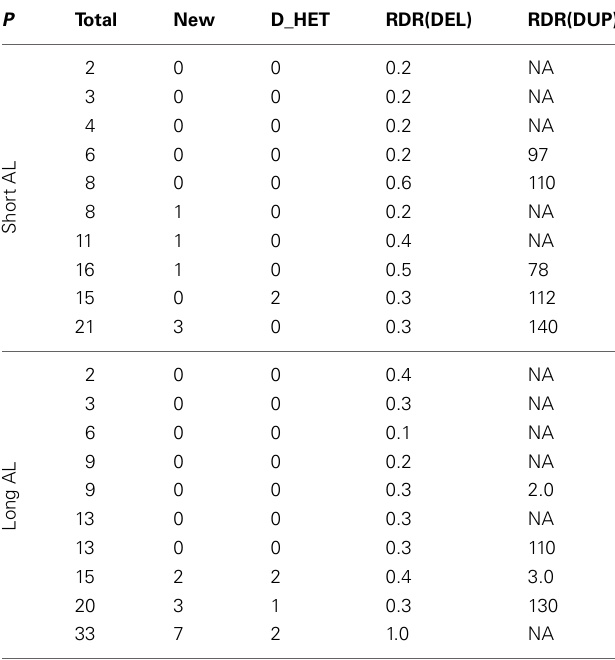
Table 3 | CNVs detected by MATCHCLIP in 20 exome sequenced samples, including 10 samples with long axial length (Long AL) and 10 samples with short axial length (Short